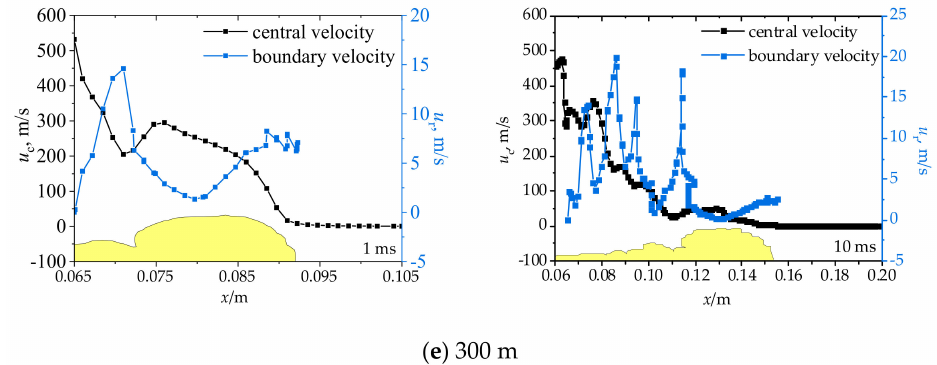
Figure 20. Velocity of jets at di ff erent water depths at the central axis and air-water interface ( a ) 1 m; ( b ) 100 m; ( c ) 150 m; ( d ) 200 m; ( e ) 300 m.